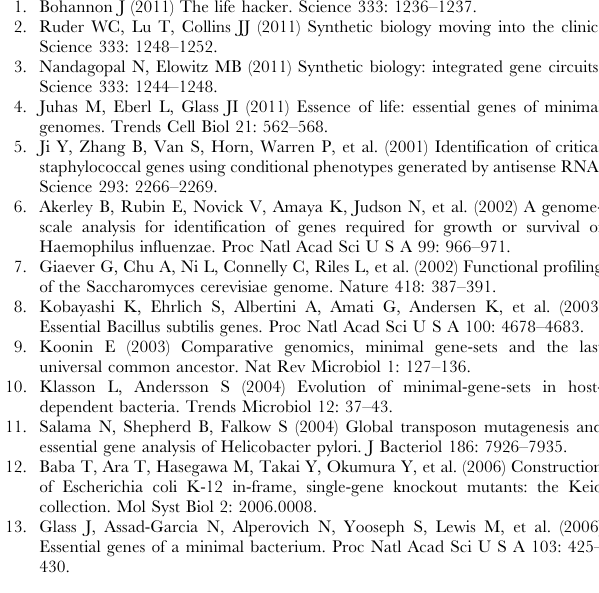
Figure S1 Generation of conditional mutants. Condition- al mutants used to investigate essentiality of selected B. cenocepacia genes were generated by replacement of the candidate essential genes native promoters for the rhamnose-inducible promoter. Short fragments (300 bp) of investigated genes were cloned into pSC200 downstream of the plasmid-borne rhamnose promoter.